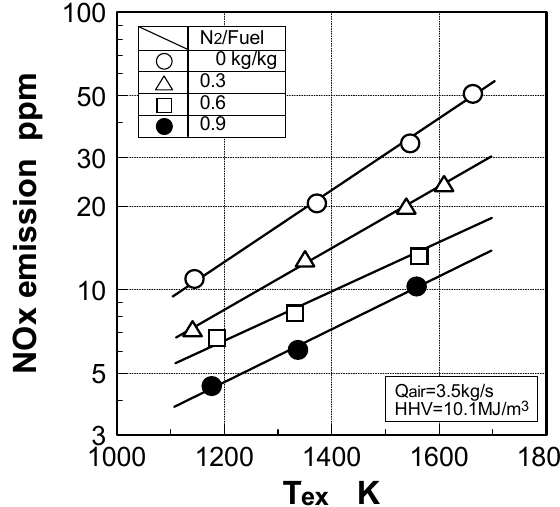
Figure 70. Effect of combustor exhaust gas temperature on NOx emission